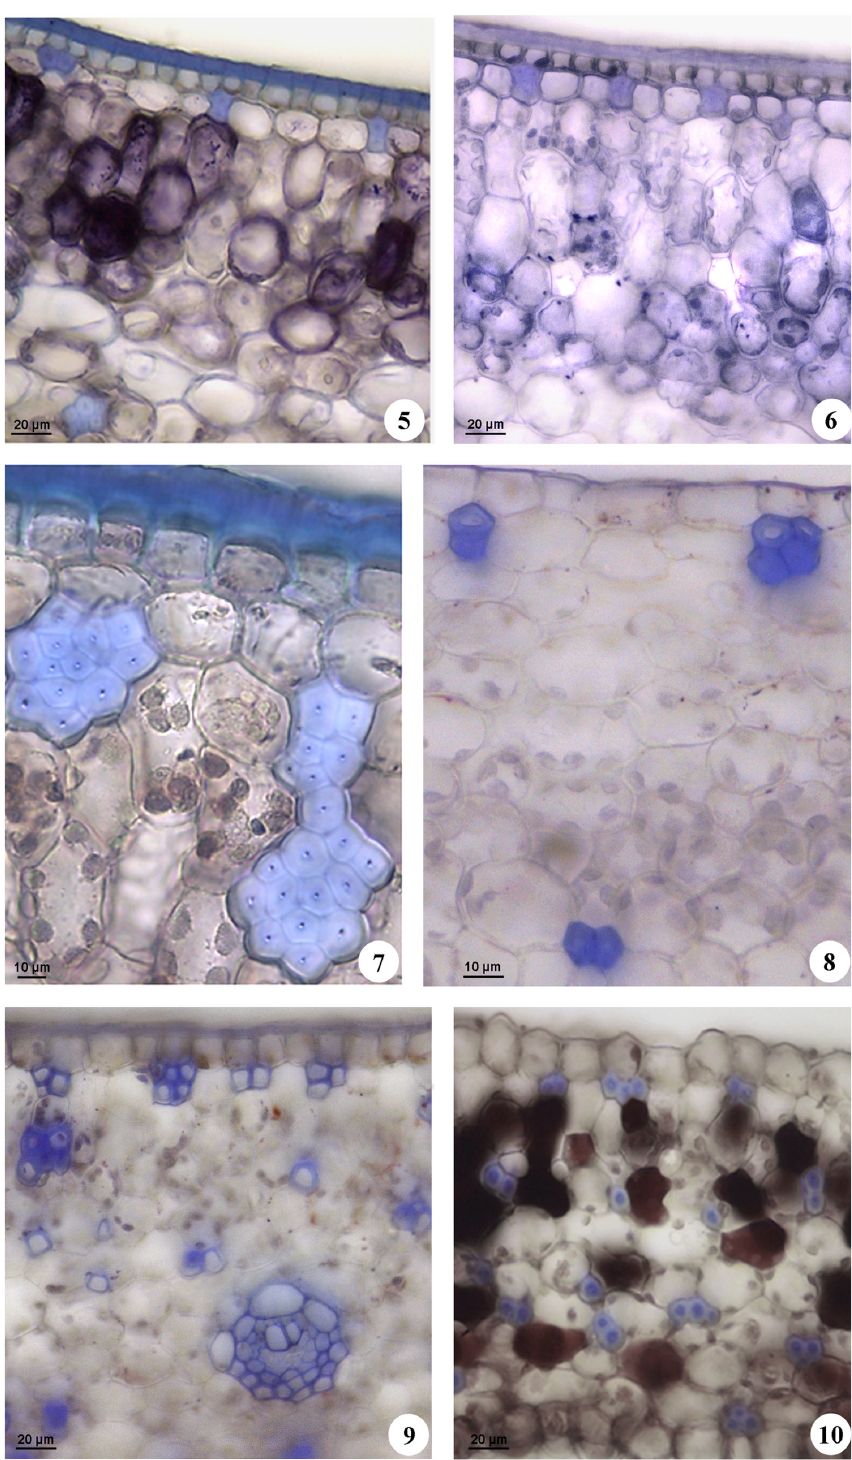
Figures 5-10 - Cross-sections of leaves of Cyclanthaceae. 5. S. cuatrecasana cuticle 100x.